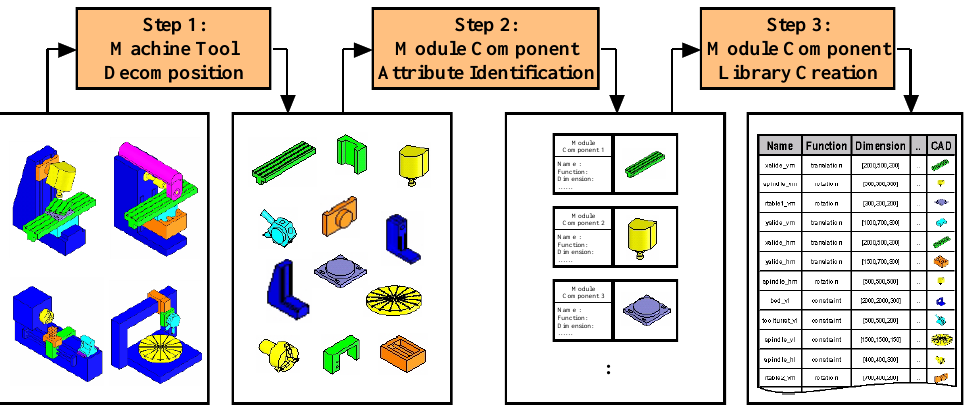
Figure 2. Module identification method.